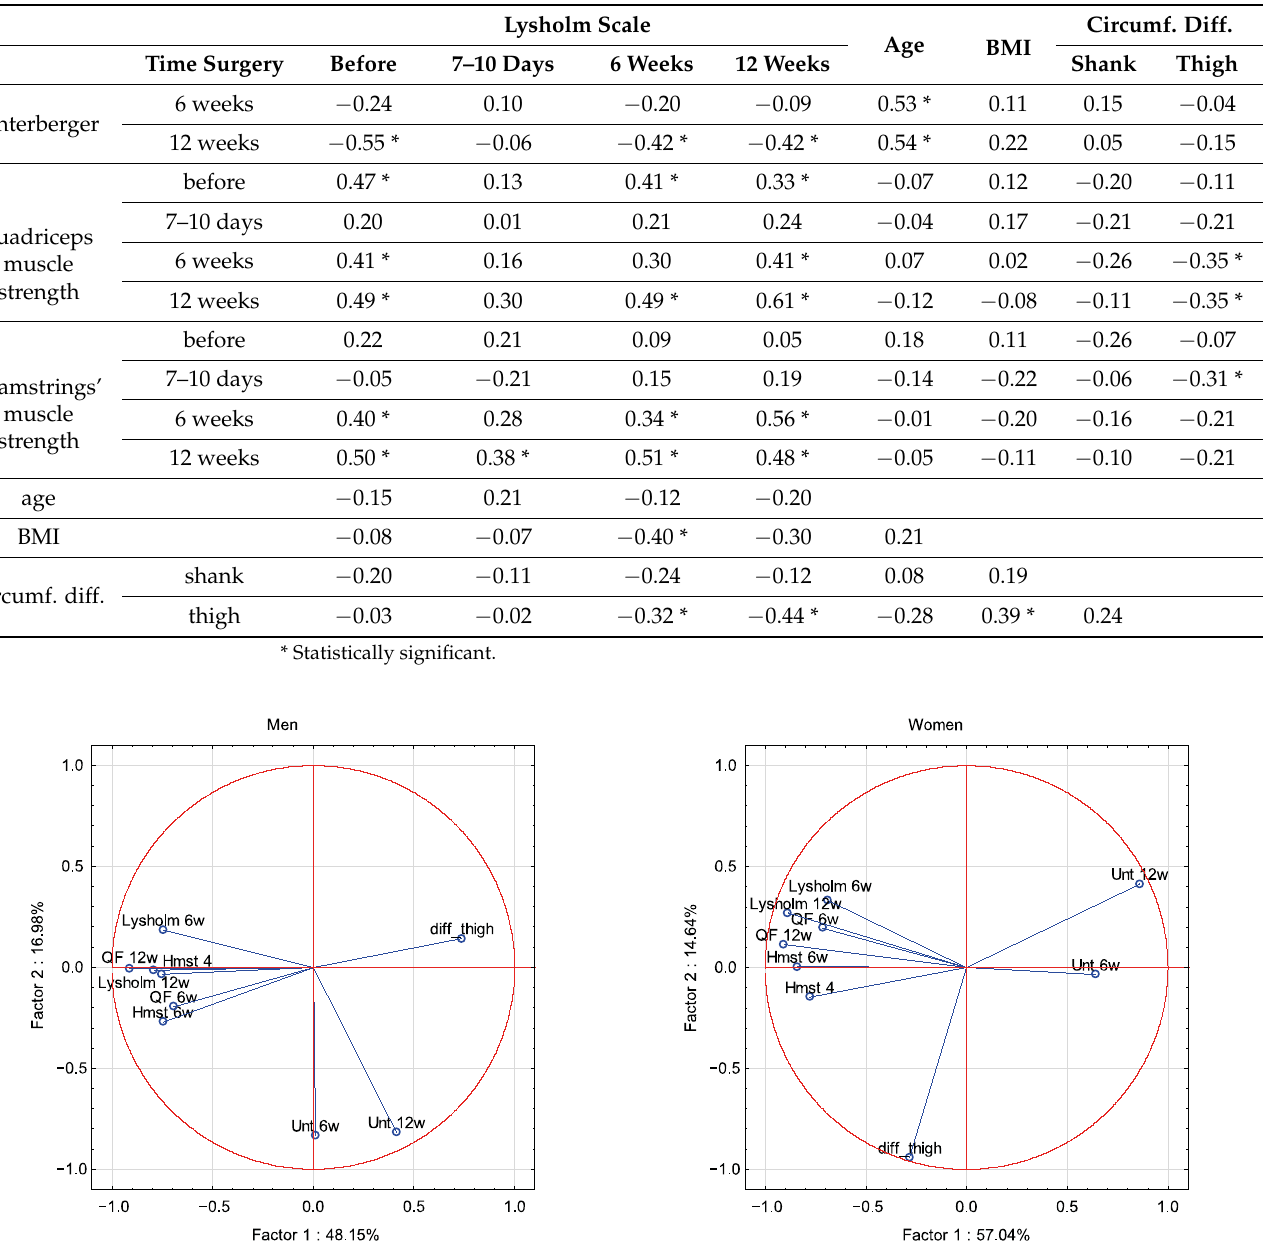
Table 4. Values of correlation coefficients between the Lysholm scale and the parameters of deep feeling, muscle strength, BMI and age. Lysholm Scale